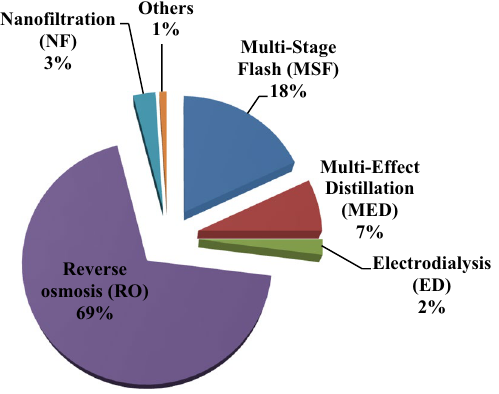
Fig. 8 The contributions of desalination methods all over the world